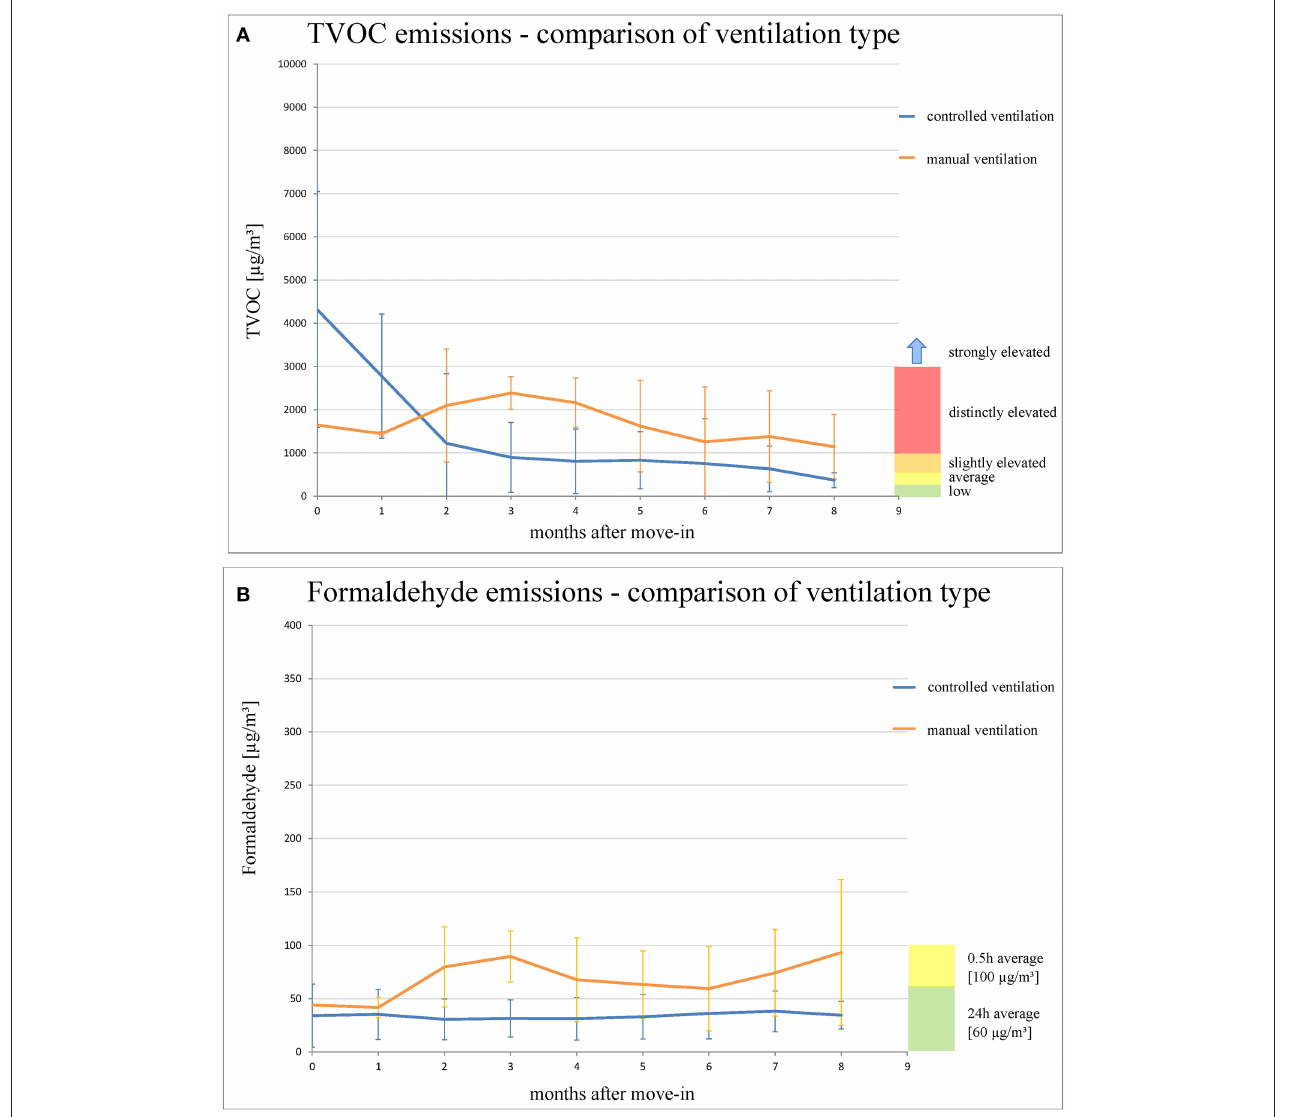
FIGURE 2 | Long-term progression of TVOC (A) and formaldehyde (B) emissions—comparison of ventilation